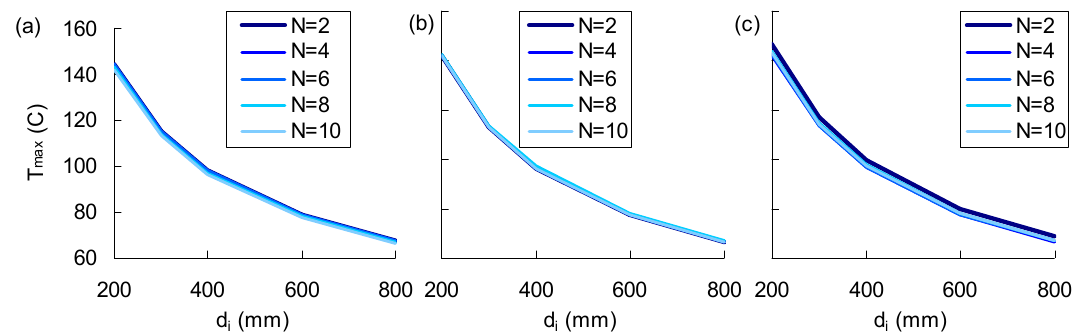
Figure 5. Maximum temperature in the stored compressed air: ( a ) 5 × 5 m column spacing; ( b ) 6 × 6 m column spacing; ( c ) 7 × 7 m column spacing.